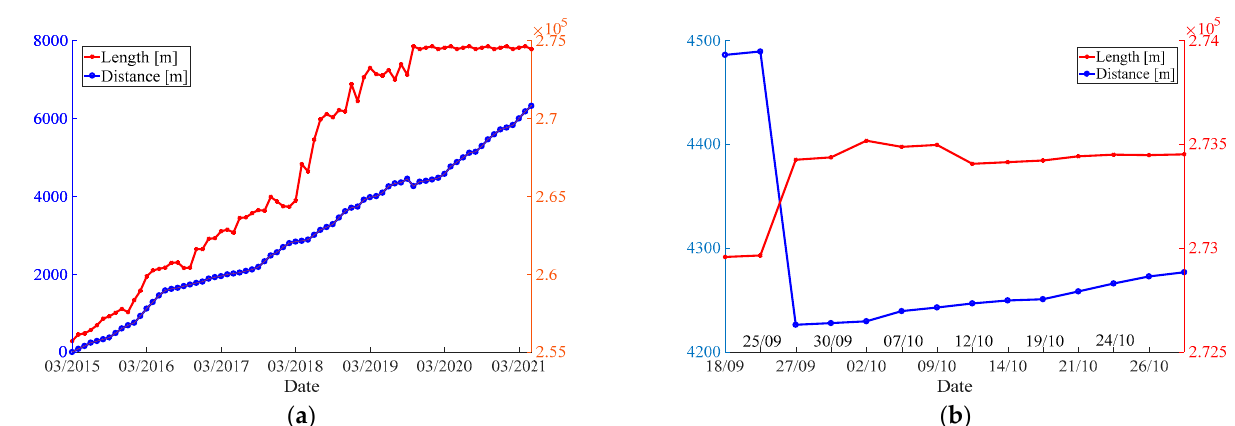
Figure 6. Time series variability in frontal lines of the AIS monitored during March 2015–May 2021. Relative changes in frontal lines of the AIS during the D28 calving event in September 2019. The length and extension distance are coded as shown. ( a ) Monthly cumulative extension distance and length of frontal line for the AIS from 2015 to 2021; ( b ) cumulative extension distance and length of frontal line for the AIS during the D28 calving event.